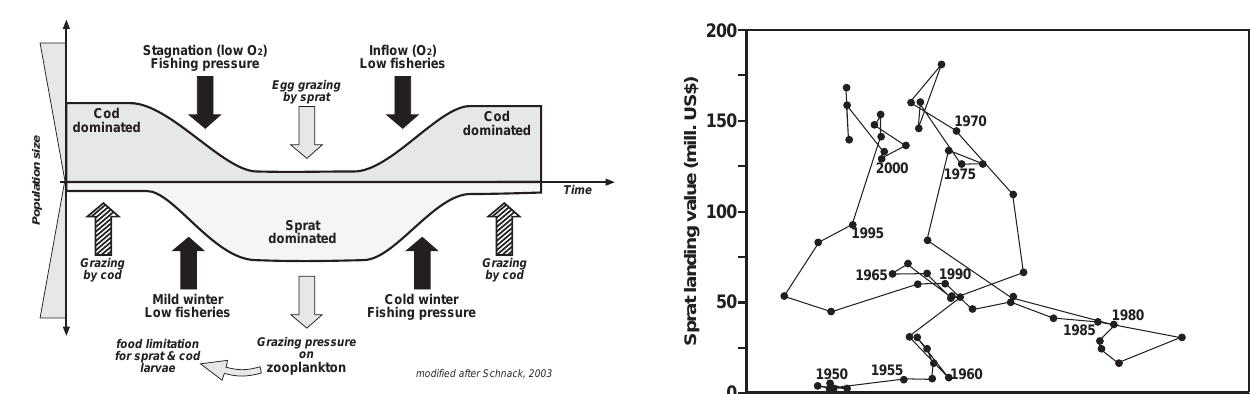
Fig. 6. Interrelationships between sprat and cod stocks, environ- mental factors, grazing, and fisheries in the Baltic Sea. The system shifts from being cod-dominated to sprat-dominated and back, as driven by environmental factors: North Sea water inflow – stagna- tion, cold winter – mild winter, biological drivers e.g. egg grazing by cod or sprat, zooplankton competition, and human activities such as cod and sprat fisheries (modified after Schnack, 2003).